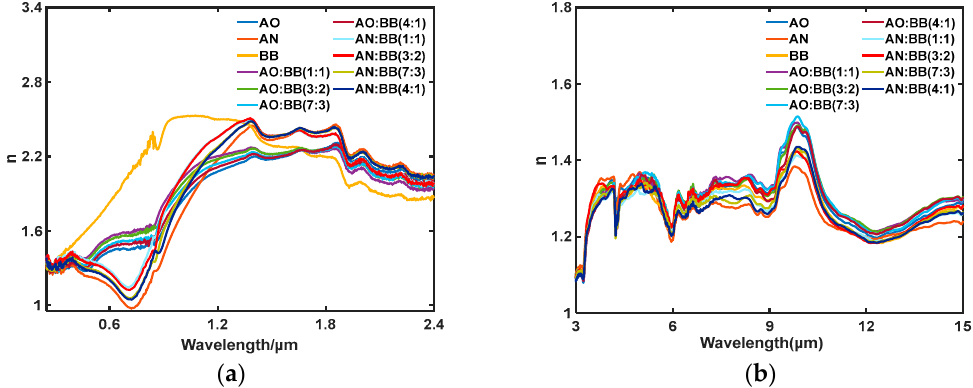
Figure 9. The real part of the complex refractive indices n ( λ ) of single-germplasm biospores and compound bioaerosols. ( a ) n ( λ ) values in the 0.25–2.4 μ m wavelength range. ( b ) n ( λ ) values in the 3–14 μ m wavelength range.